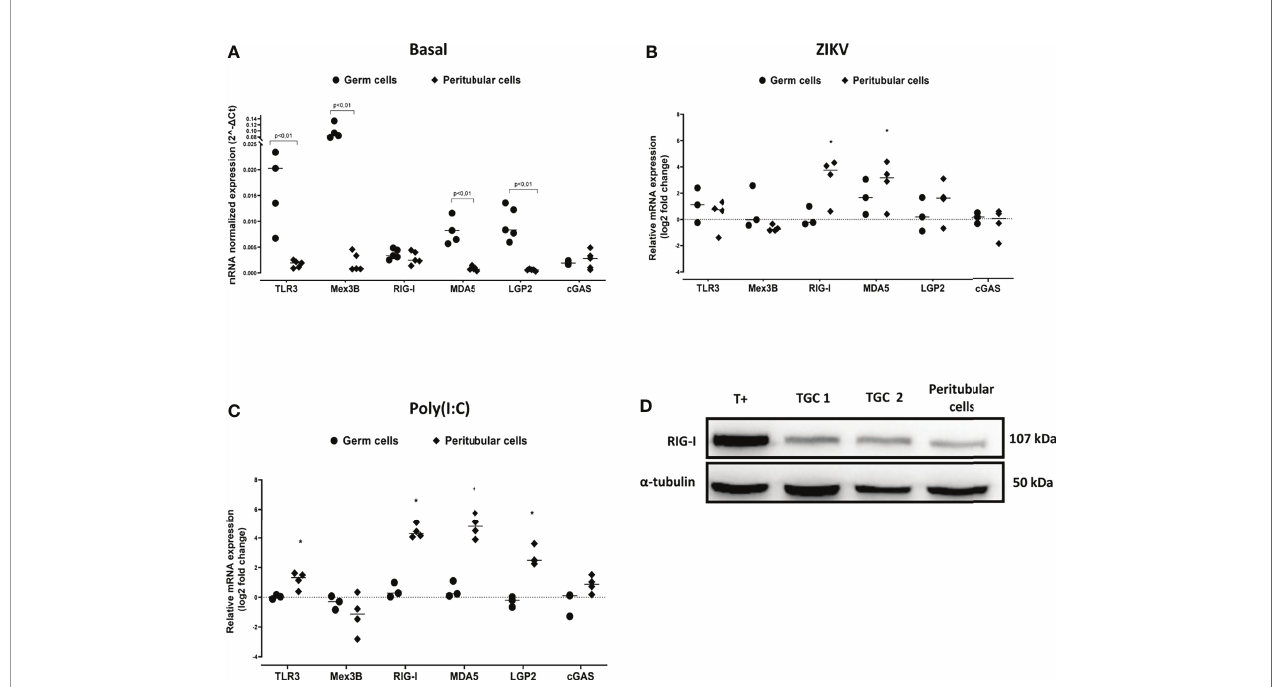
FIGURE 4 | PRR sensing RNA virus expression in human isolated testicular germ cells and peritubular cells. PRR sensing RNA virus expression in human isolated testicular cells was determined by RTqPCR. Graphics show their basal level expression (A) or their expression in log2-transformed ratios between 72h ZIKV-infected (B) or 4h Poly(I:C) 10µg/mL stimulated (C) and time-matched mock-exposed controls. Each dot corresponds to different donor (n=5 for basal expression, n= 3 to 4 for ZIKV and Poly(I:C) exposed cell cultures), and each symbol represents one cell type. Horizontal bars represent the median values. Mann Whitney